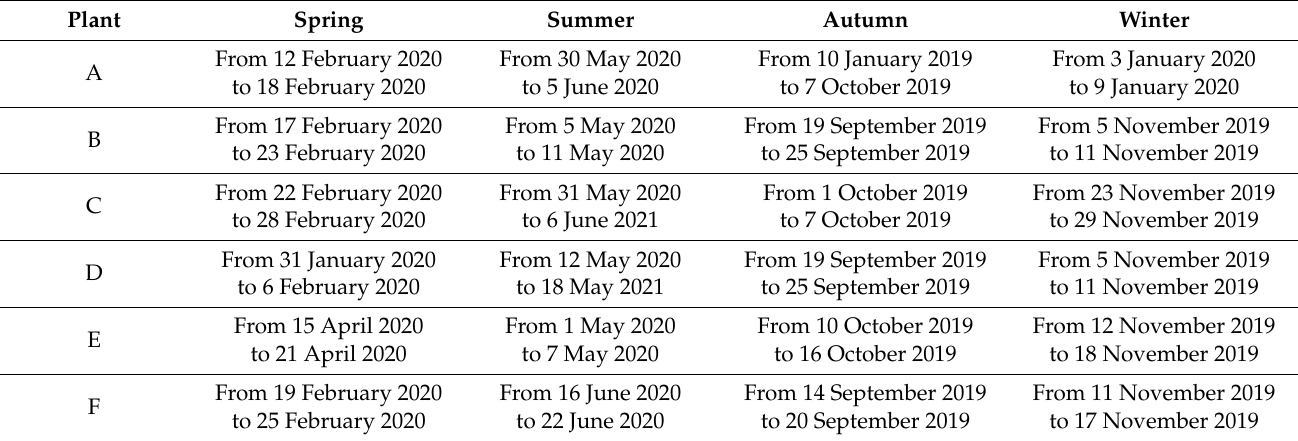
Table 4. Summary of data record period during one week for six actual solar power plants in Taiwan. Plant